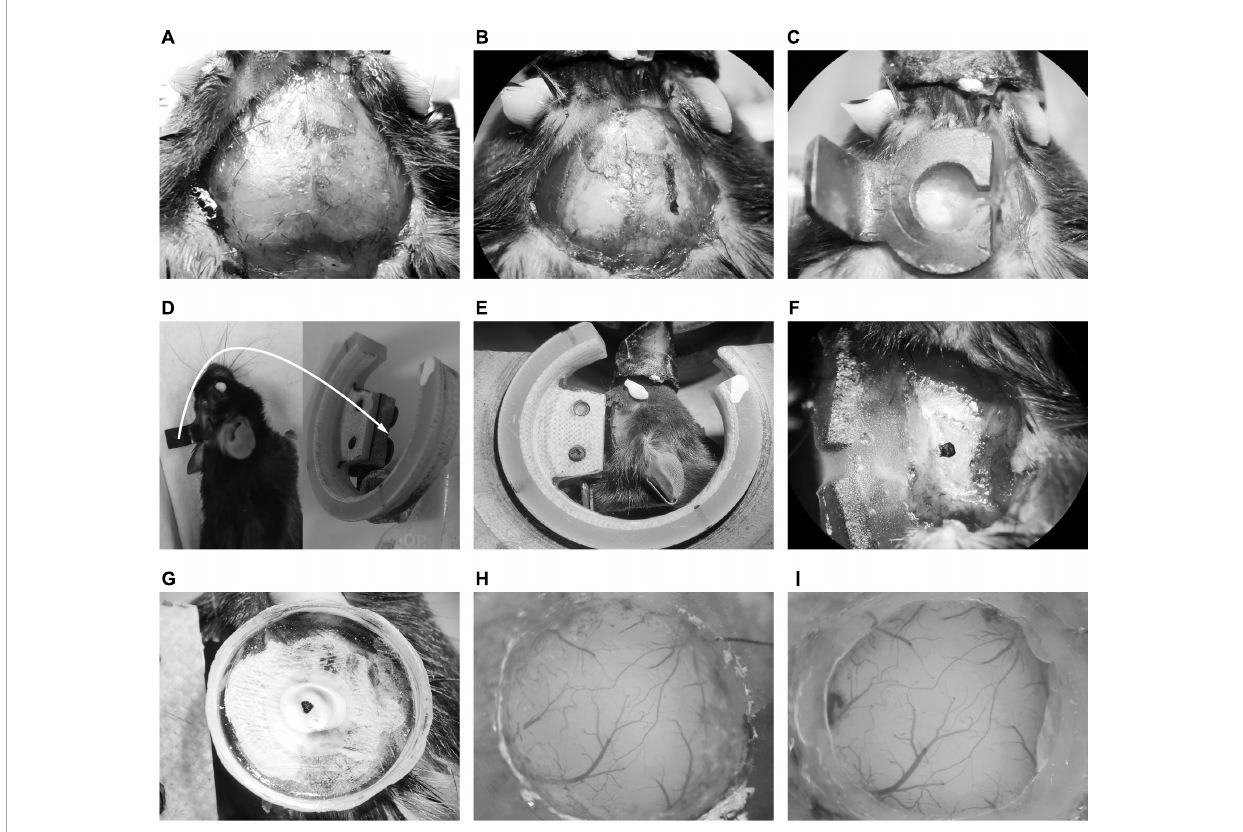
FIGURE2 Illustration of chronic cranial window implantation. (A) Skin removal and tissue cleaning. (B) The lateral edge marking of the head-post. (C) Fixation of the head-post with dental cement. (D) The mice embedded with head-post (left) and the head-post holder (right). The white arrow indicated that the long handle of the head-post was connected to the slot of the recording holder with two screws. (E) The head fixing mice on the head-post holder. (F) Exposure of temporal skull. (G) Fixation of the recording chamber. (H) The craniotomy of AuC. (I) The cranial window embedding of